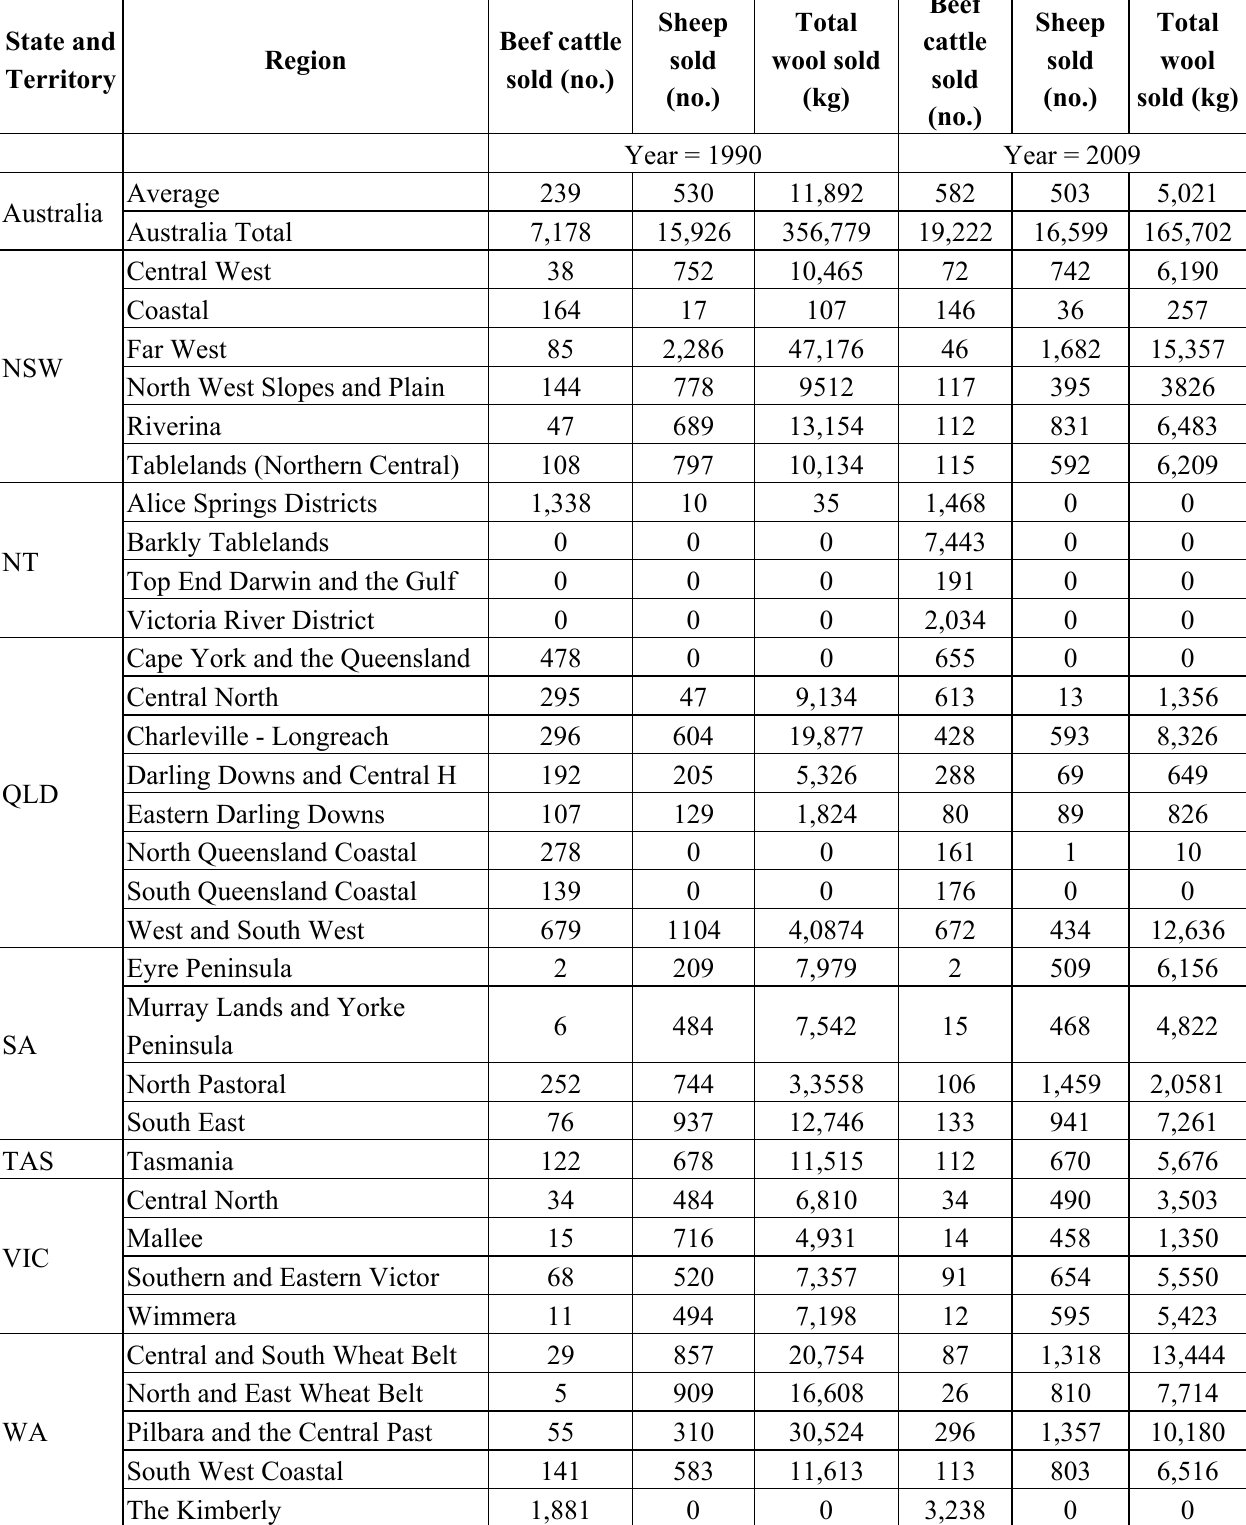
Table 9. Livestock sales per farm business in Australian regions in 1990 and